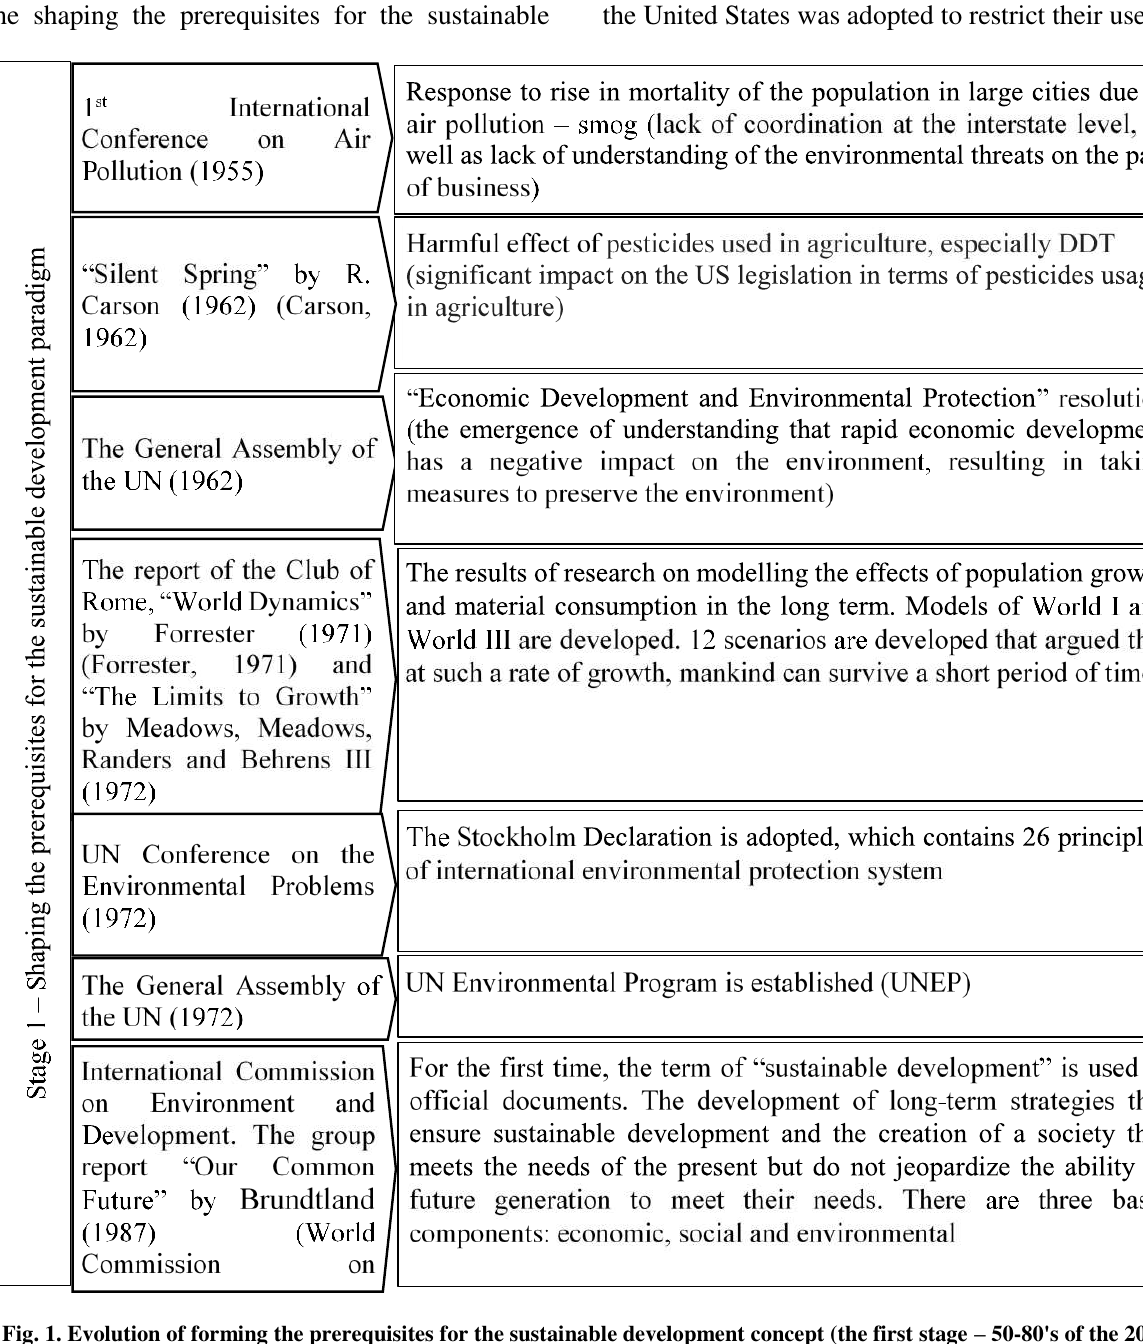
Fig. 1. Evolution of forming the prerequisites for the sustainable development concept (the first stage – 50-80's of the 20th